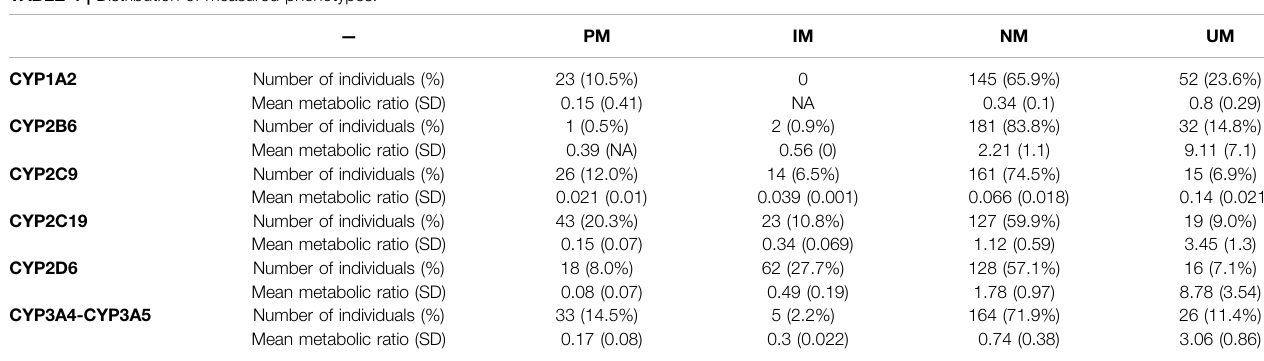
TABLE 4 | Distribution of measured